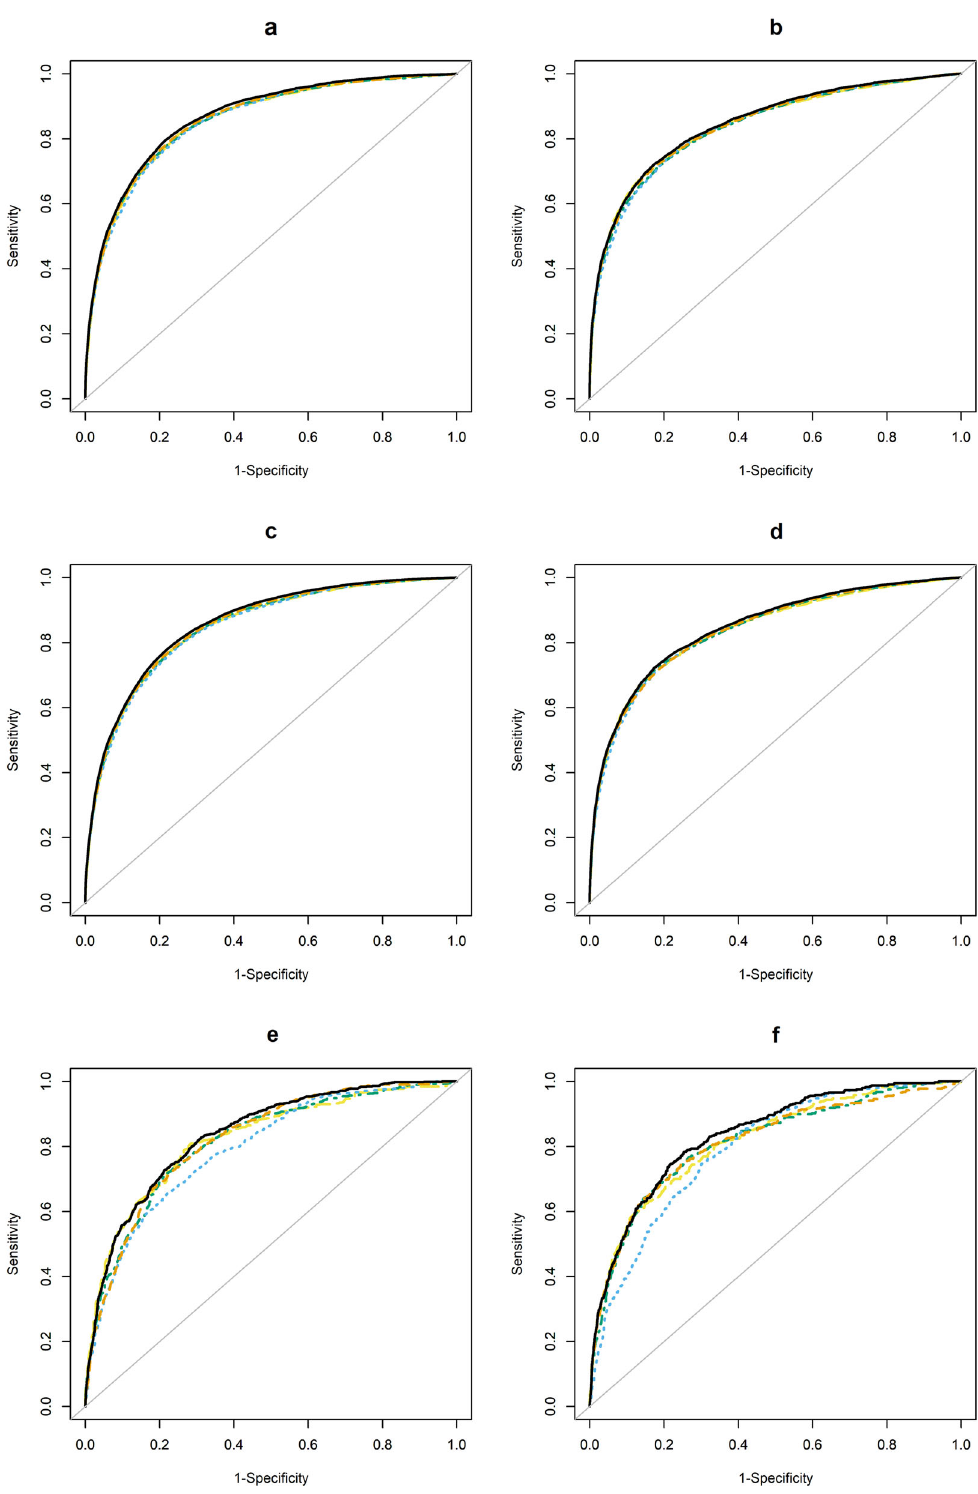
Fig. 1 Receiver operating characteristic (ROC) curves for each prediction modeling approach (using optimal tuning parameters, estimated in the validation dataset) in both settings (mental health specialty and general medical) for 30- and 90-day suicide attempt (fatal and nonfatal) models and 90-day suicide death models. Each fi gure panel represents ROC curves for different samples, outcomes, and follow-up periods. ( a ): 30-day suicide attempt prediction models, mental health specialty visits; ( b ): 30-day suicide attempt prediction models, general medical visits; ( c ): 90-day suicide attempt prediction models, mental health specialty visits; ( d ): 90-day suicide attempt prediction models, general medical visits; ( e ): 90-day suicide prediction models, mental health specialty visits; ( f ): 30-day suicide prediction models, general medical visits. Original parsimonious (yellow long-dashed line); Logistic regression with lasso variable selection (green long-short- dashed line); Random forest (blue short-dashed line); Arti fi cial neural network (orange medium-dashed line); Ensemble = ensemble model using logistic regression, random forests, and arti fi cial neural networks with detailed temporal predictors (solid black